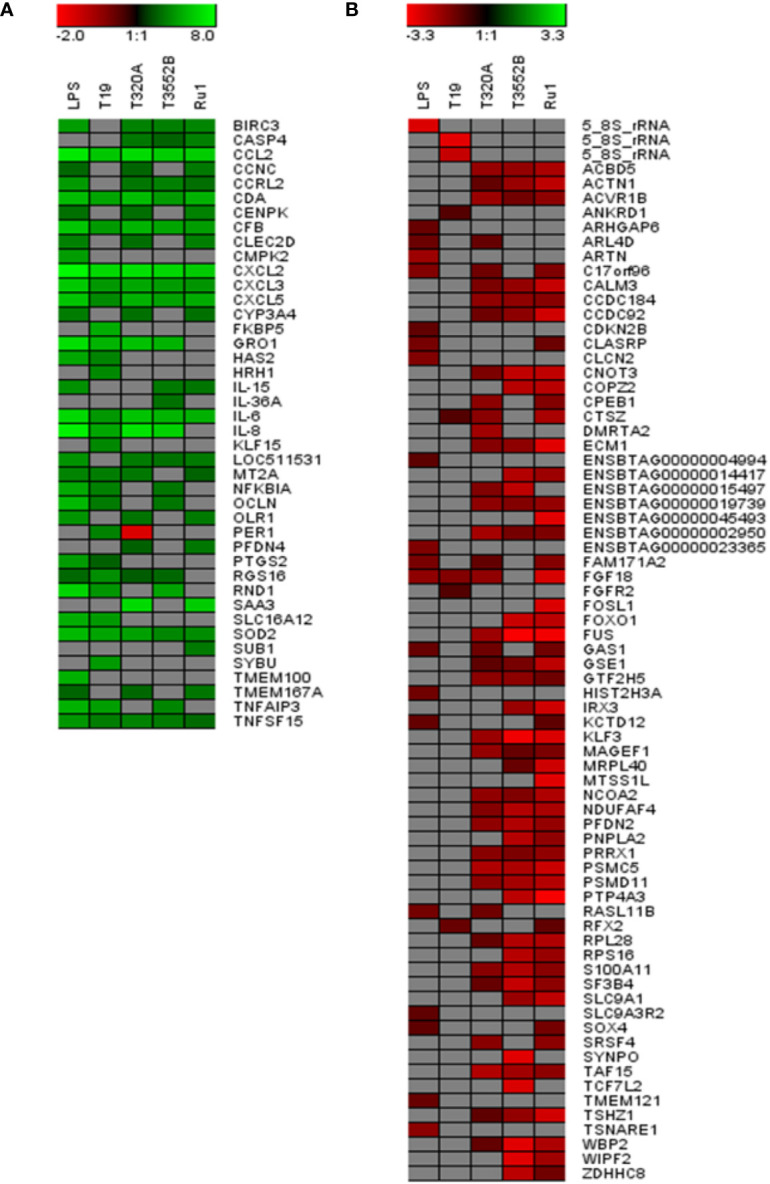
Comparison of the 20 most increased and decreased mRNA transcripts in primary bovine foot skin fibroblasts challenged with pathogenic or commensal treponemes. Heatmaps comparing the 20 most (A) increased and (B) decreased mRNA transcripts (FDR-adjusted p value ≤0.05 and a log2 fold change ≥1 and ≤−1) in bovine foot skin fibroblasts challenged with T. medium phylogroup (strain T19), T. phagedenis phylogroup (strain T320A), T. pedis (strain T3552BT) and T. ruminis (strain Ru1T). Transcripts are given in abbreviated form against the corresponding bars, and expression bars above each heatmap illustrate the degree of increased (green) or decreased (red) expression (log2 fold change). Gray squares indicate that no significant difference was identified compared to the media control group. Data represents the mean differential transcript expression of three independent experimental replicates per challenge group (n = 3), with both T. phagedenis and T. ruminis represented by an additional technical replicate (n = 4).